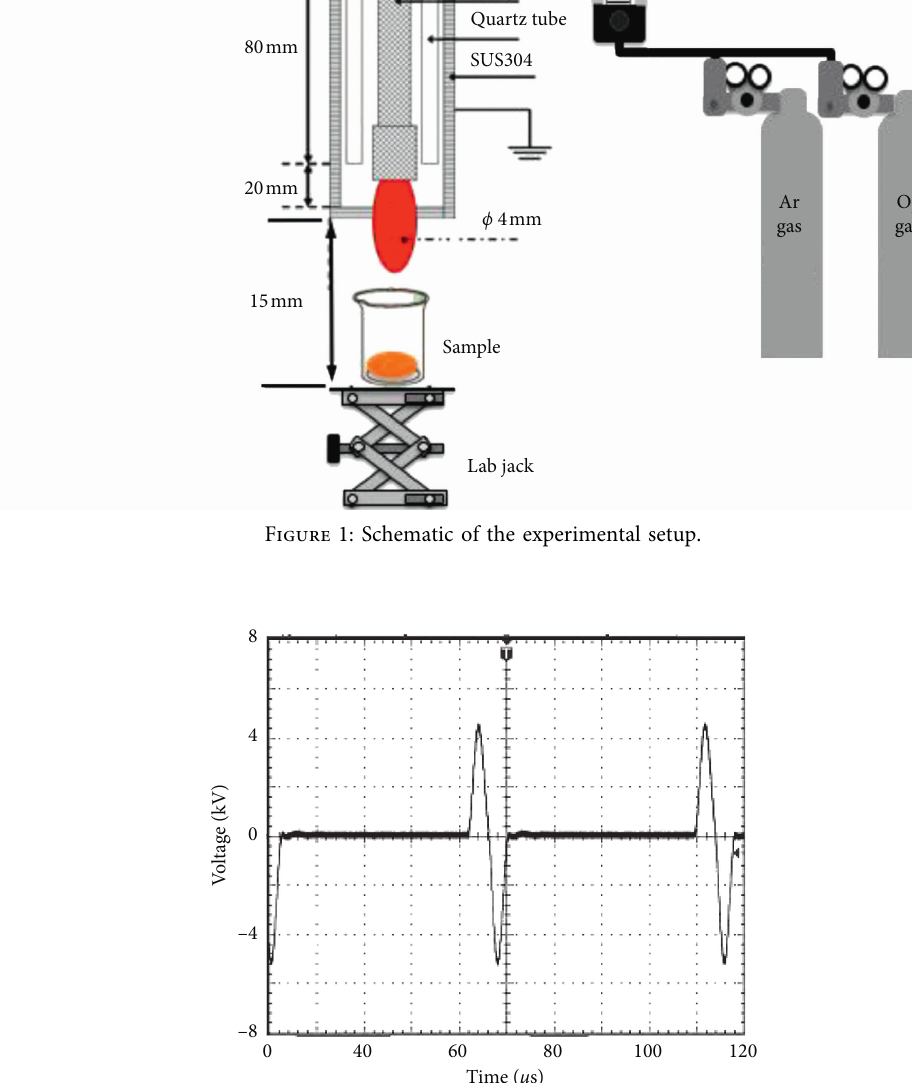
Figure 2: The oscillogram of the voltage waveforms (pulse frequency: 10 kHz and plasma power